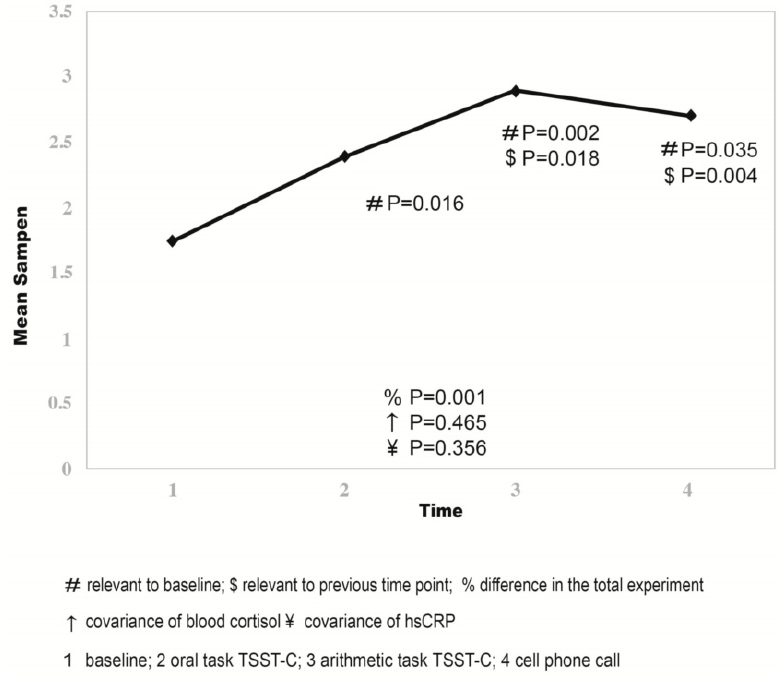
Figure 2. Mean SampEn in each experimental period. Table 2. Mean Sample Entropy during baseline and consecutive exposures ± SD (n = 18).